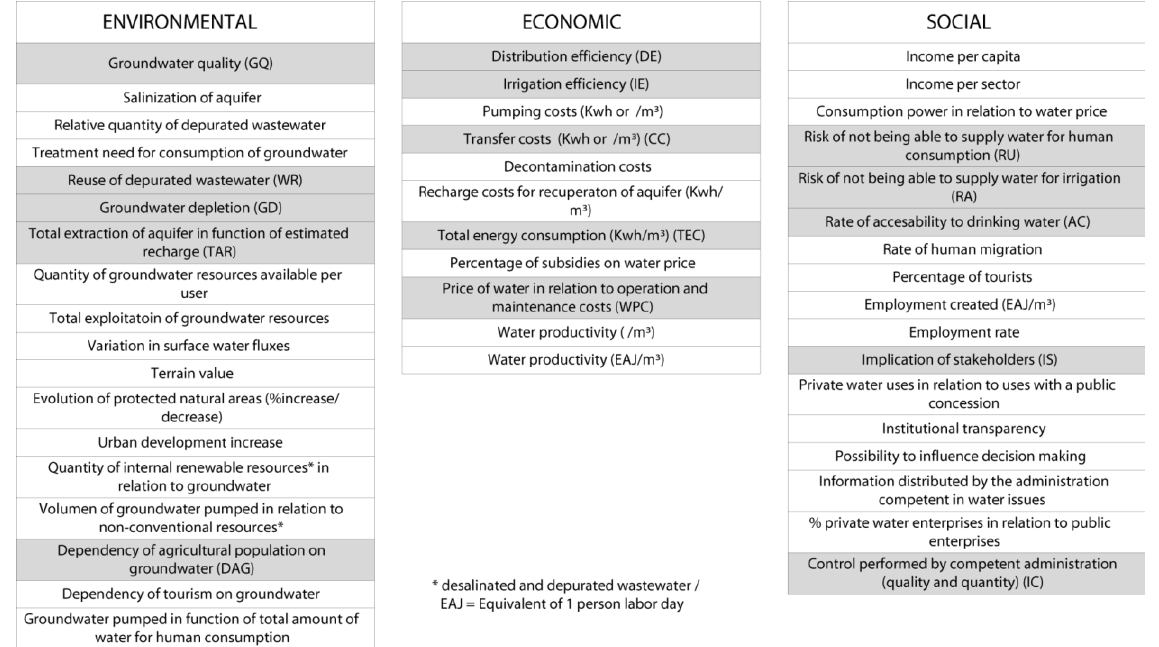
Figure A1.2: List of indicators based on literature presented to the multi stakeholder working group and highlighted selected indicators (5 environmental, 5 social and 5